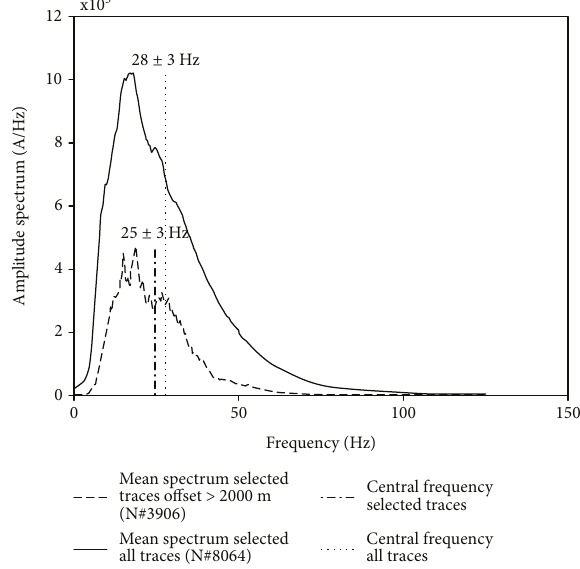
Figure 7: Raw data spectral analysis and central frequency estimate: mean spectrum on all traces (continuous line) and mean spectrum of selected trace with o ff sets greater than 2000m (dashed line). Vertical lines indicate the central frequency